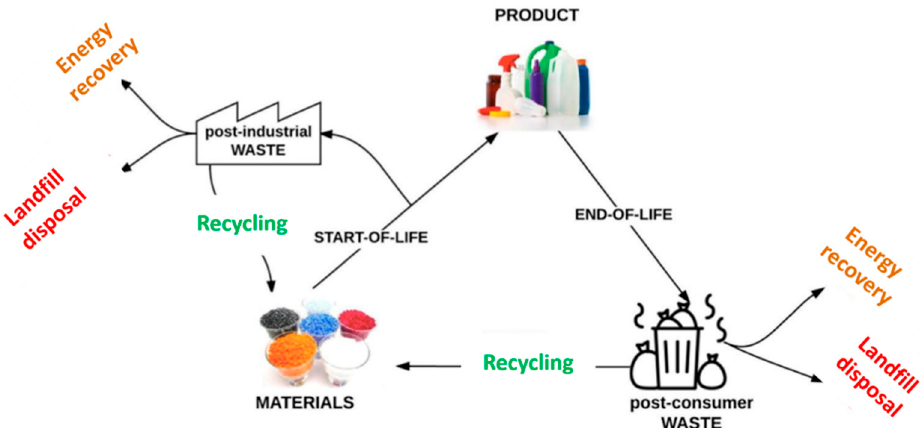
Figure 1. Lifecycle and routes for energy recovery, landfill disposal and recycling of plastic materials (Adapted from [82]. Reprinted from Waste Management, Vol 69, Ragaert et al., Mechanical and chemical recycling of solid plastic waste, 24–58. Copyright (2017), with permission from Elsevier).